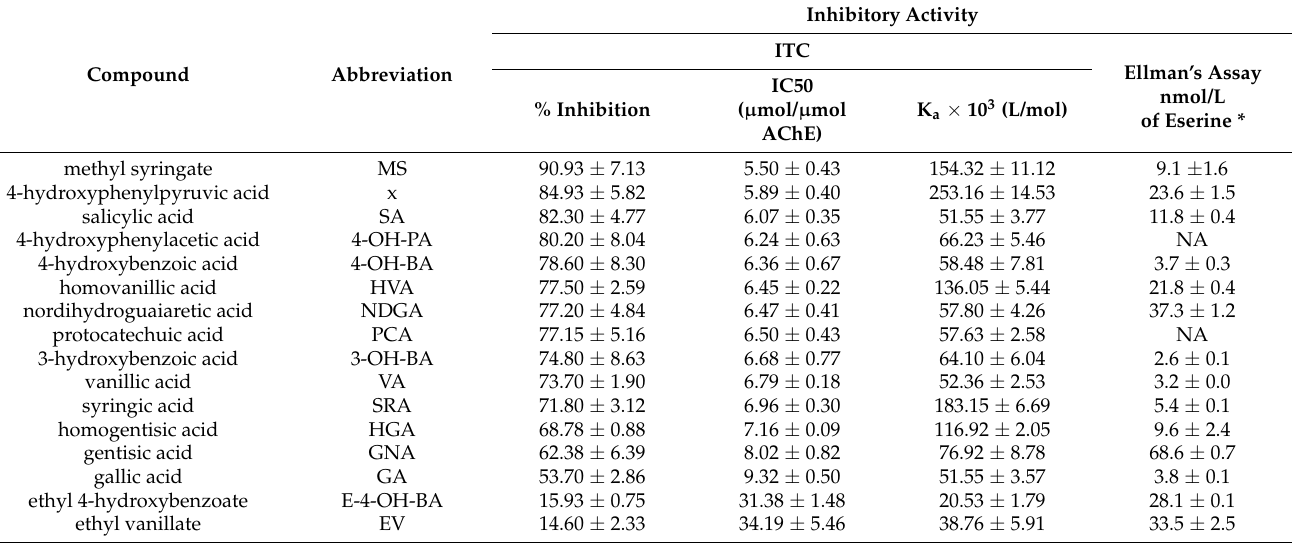
Table 1. Anti-AChE activity studied by ITC method and comparison with colorimetric method results. * Reprinted/adapted with permission from Refs. [23–25]. 2022, Dominik